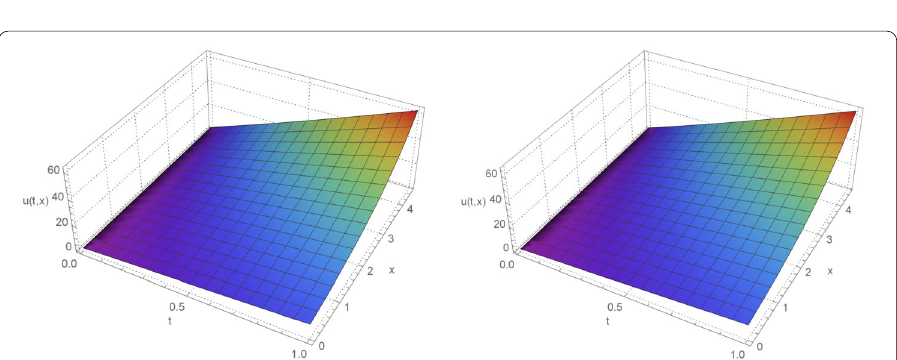
Figure 7 RPSM vs. q-HAM for Case II for U (2) ( t , x ) with β = 0.1, γ = 0.1 and α =